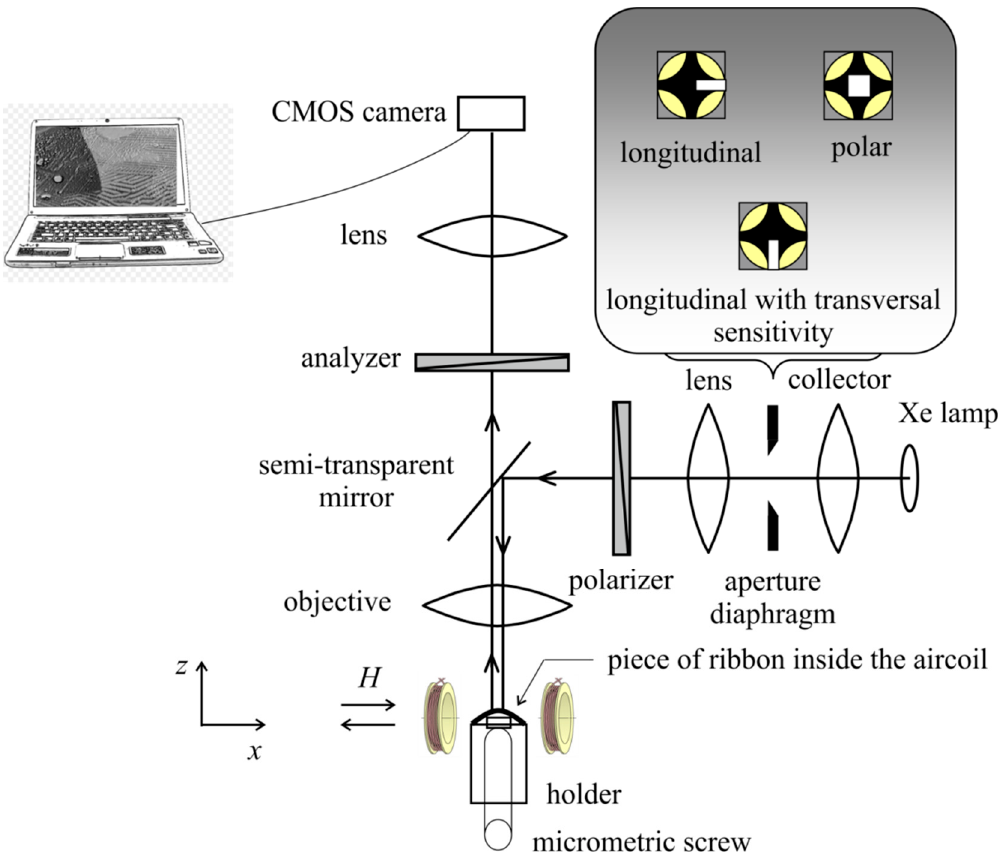
Figure 2. Schema of experiment: magneto-optical Kerr microscope, sample holder, and sample placed into magnetic field produced by couple of coils.